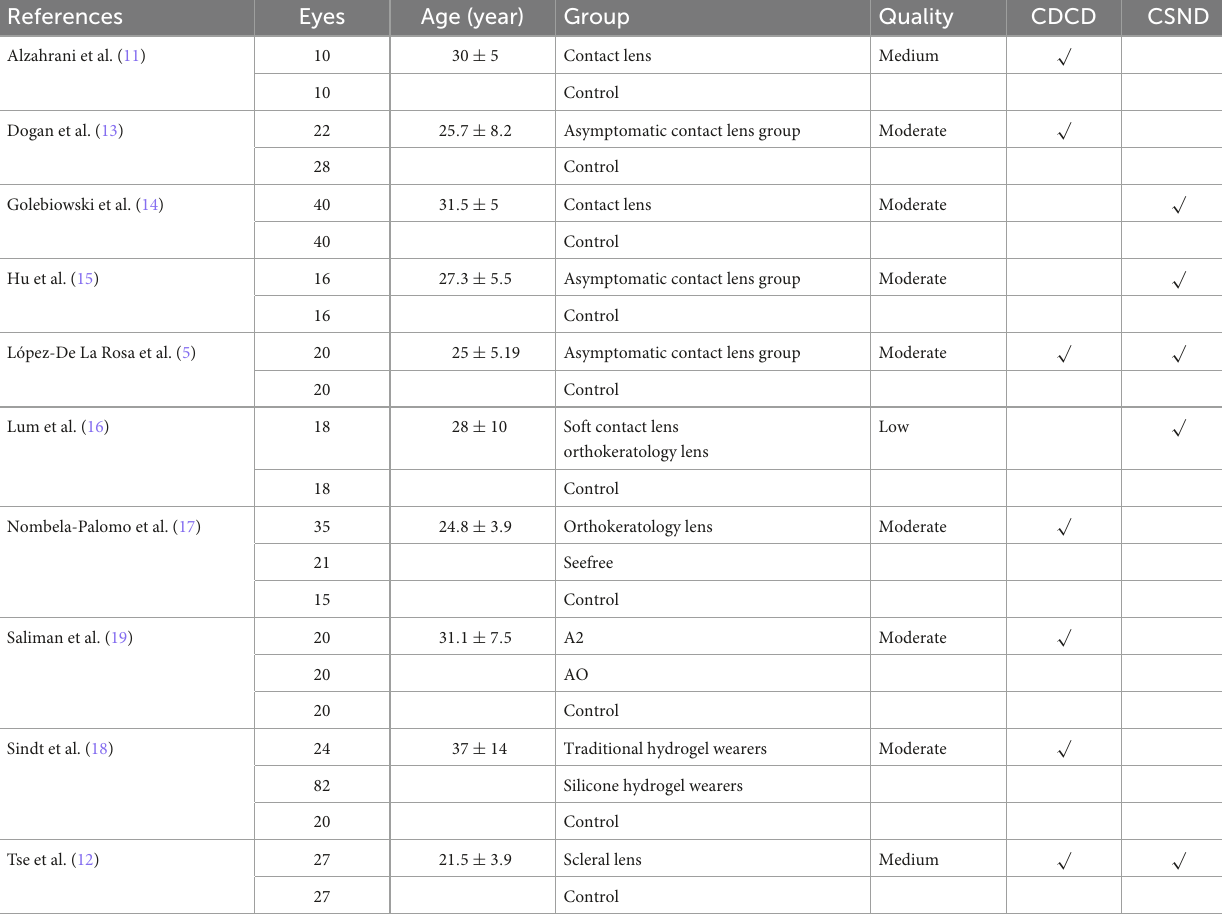
TABLE 1 Characteristics of the included studies.